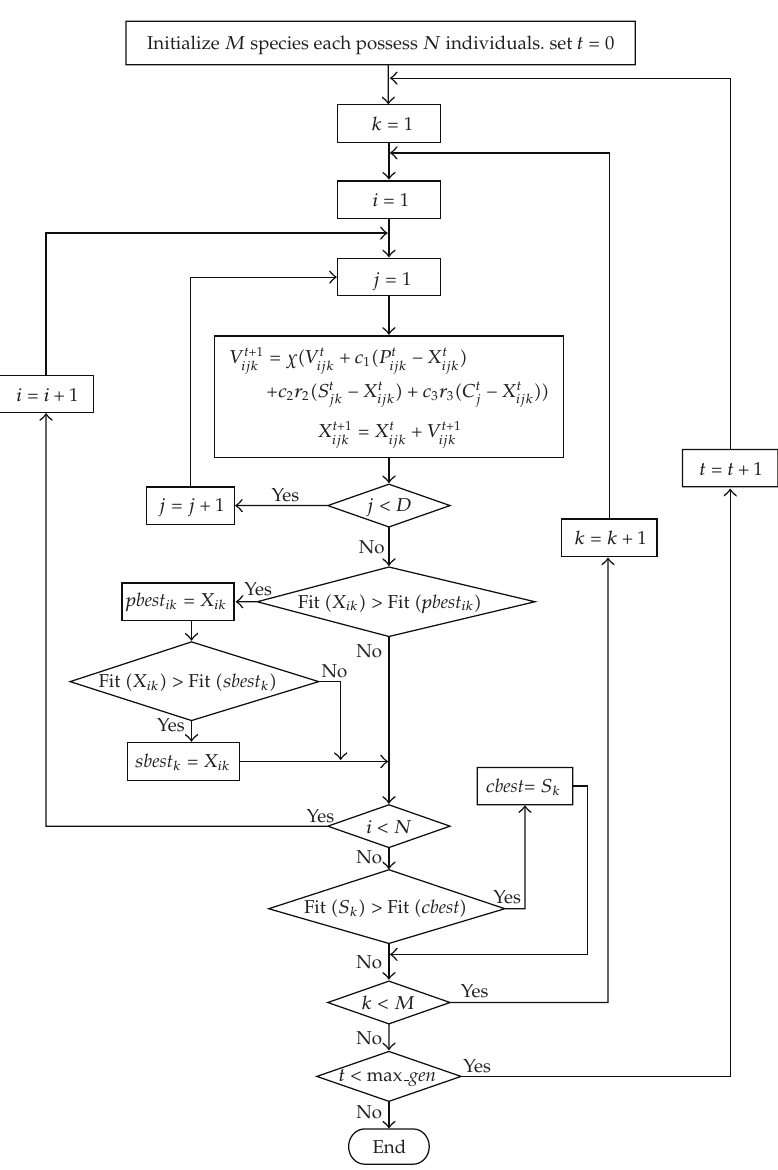
Figure 7: Flowchart of the PS 2 O